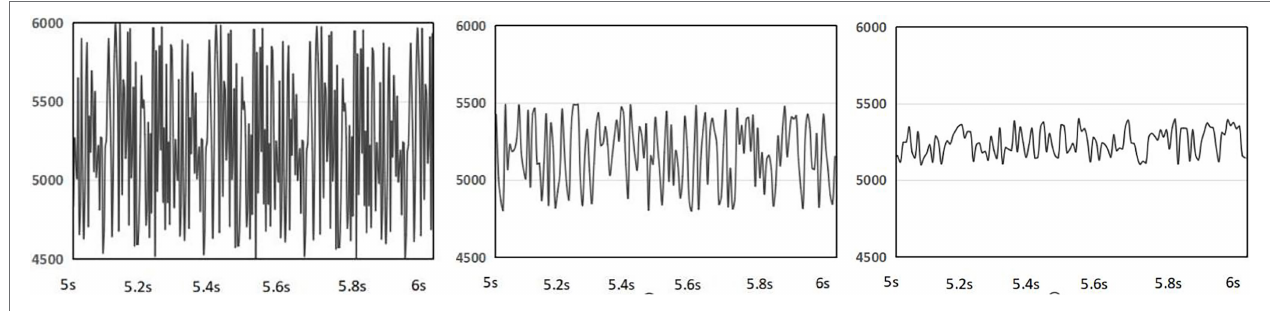
FIGURE 4 | Diagram of the filtering process results.